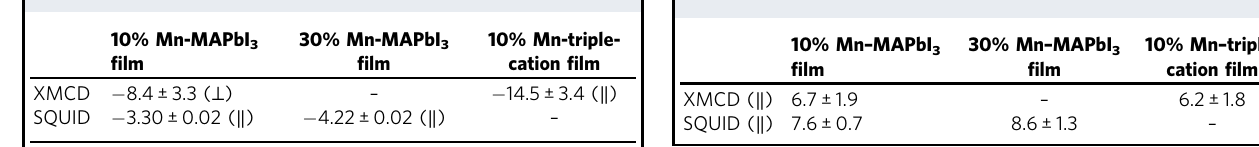
Table 3 Magnetic moment in μ B values extracted from temperature-dependent measurements (Fig. 5), fi tted with Brillouin function.